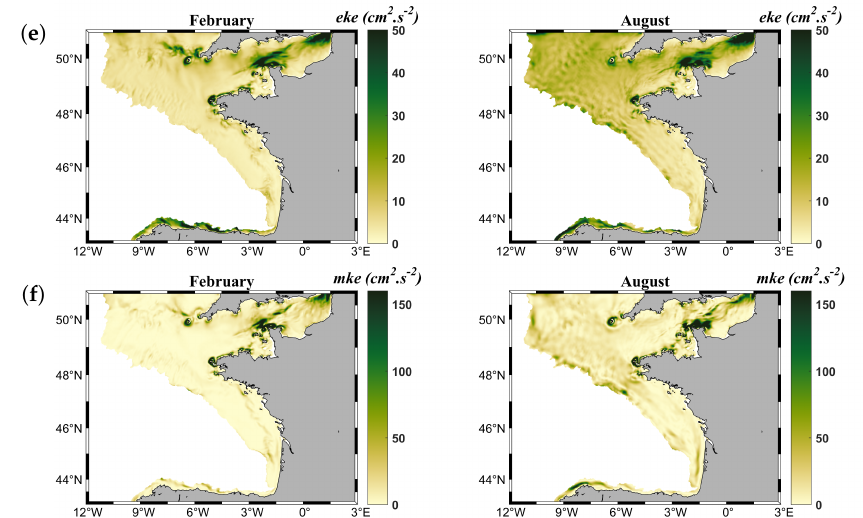
Figure 3. Illustration of monthly dynamical EOVs in February ( left ) and August ( right ): ( a ) Root Mean Square (computed over one month) of low frequency currents filtered of the tidal component (RMS_FILT), ( b ) Root Mean Square (computed over one month) of high frequency (tidal) currents (RMS_TIDE), ( c ) Okubo–Weiss criterion (OW), ( d ) relative vorticity (RVORT), ( e ) Eddy Kinetic Energy (EKE) and ( f ) Mean Kinetic Energy